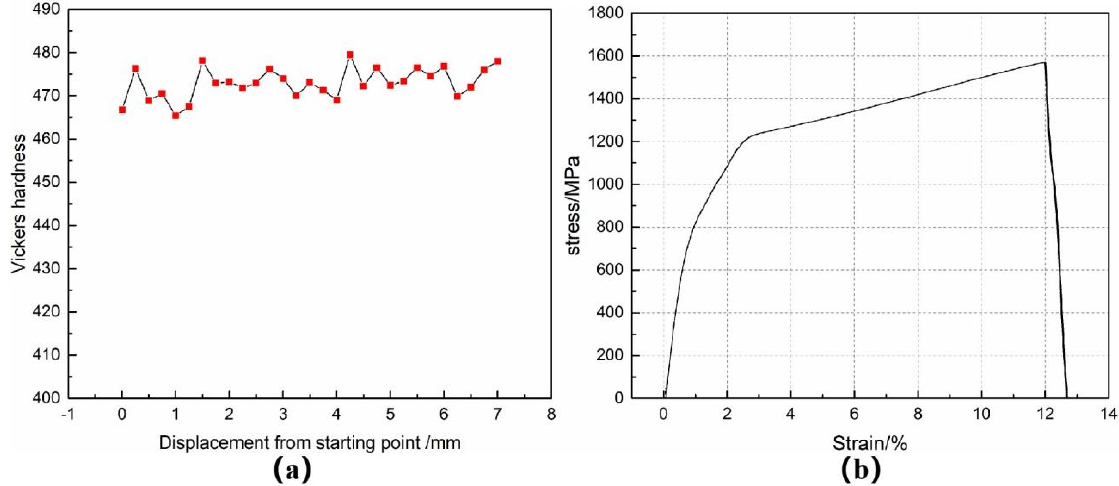
Figure 5. ( a ) Microhardness curve, ( b ) tensile stress–strain curve.